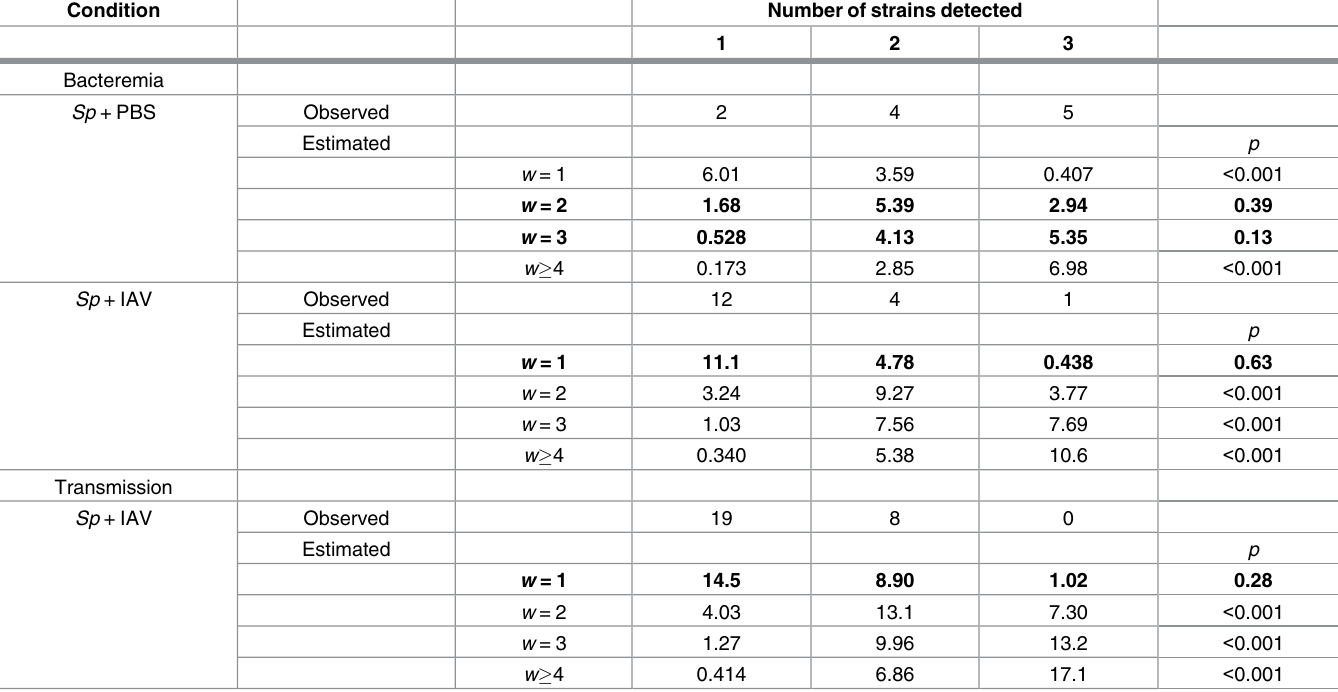
infected mice, there was daily shedding of each of the three mutants ( Fig 2B1 ) and all pups were colonized by and shed all three strains ( Fig 2B2 ), indicating a lack of a bottleneck during the exit of bacteria (Table 1 ). To examine whether there is a bottleneck during entry into the recipient, the experimental conditions were changed. Three index mice, each colonized at age 4 days with one of the three mutants, were used per litter to test whether there could be multiple Table 2. Conditions with a tight population